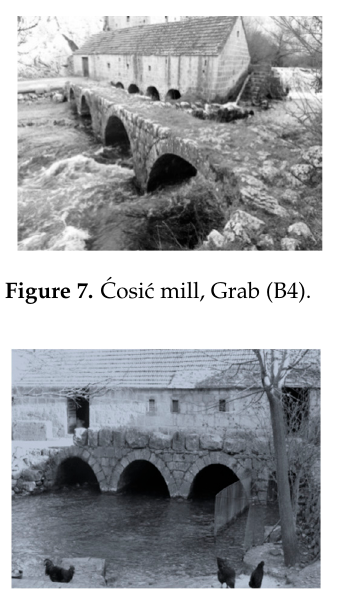
Figure 6. Castel Vitturi, Kaštel Lukši ć (B3).